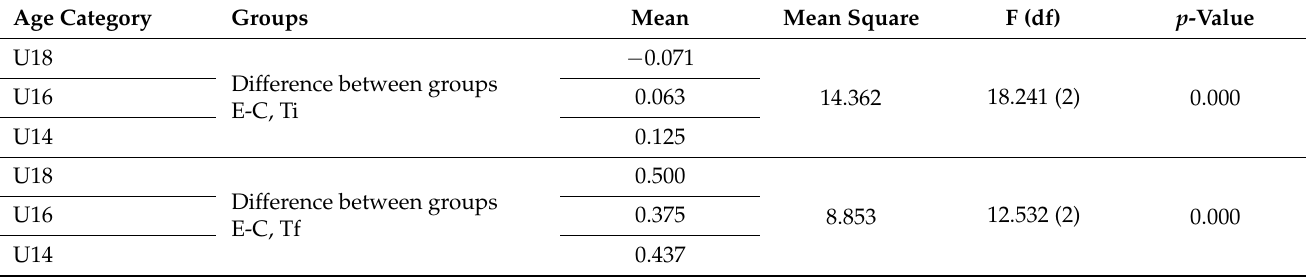
Table 4. ANOVA between U14, U16, and U18 for the Shoot-Run Test.